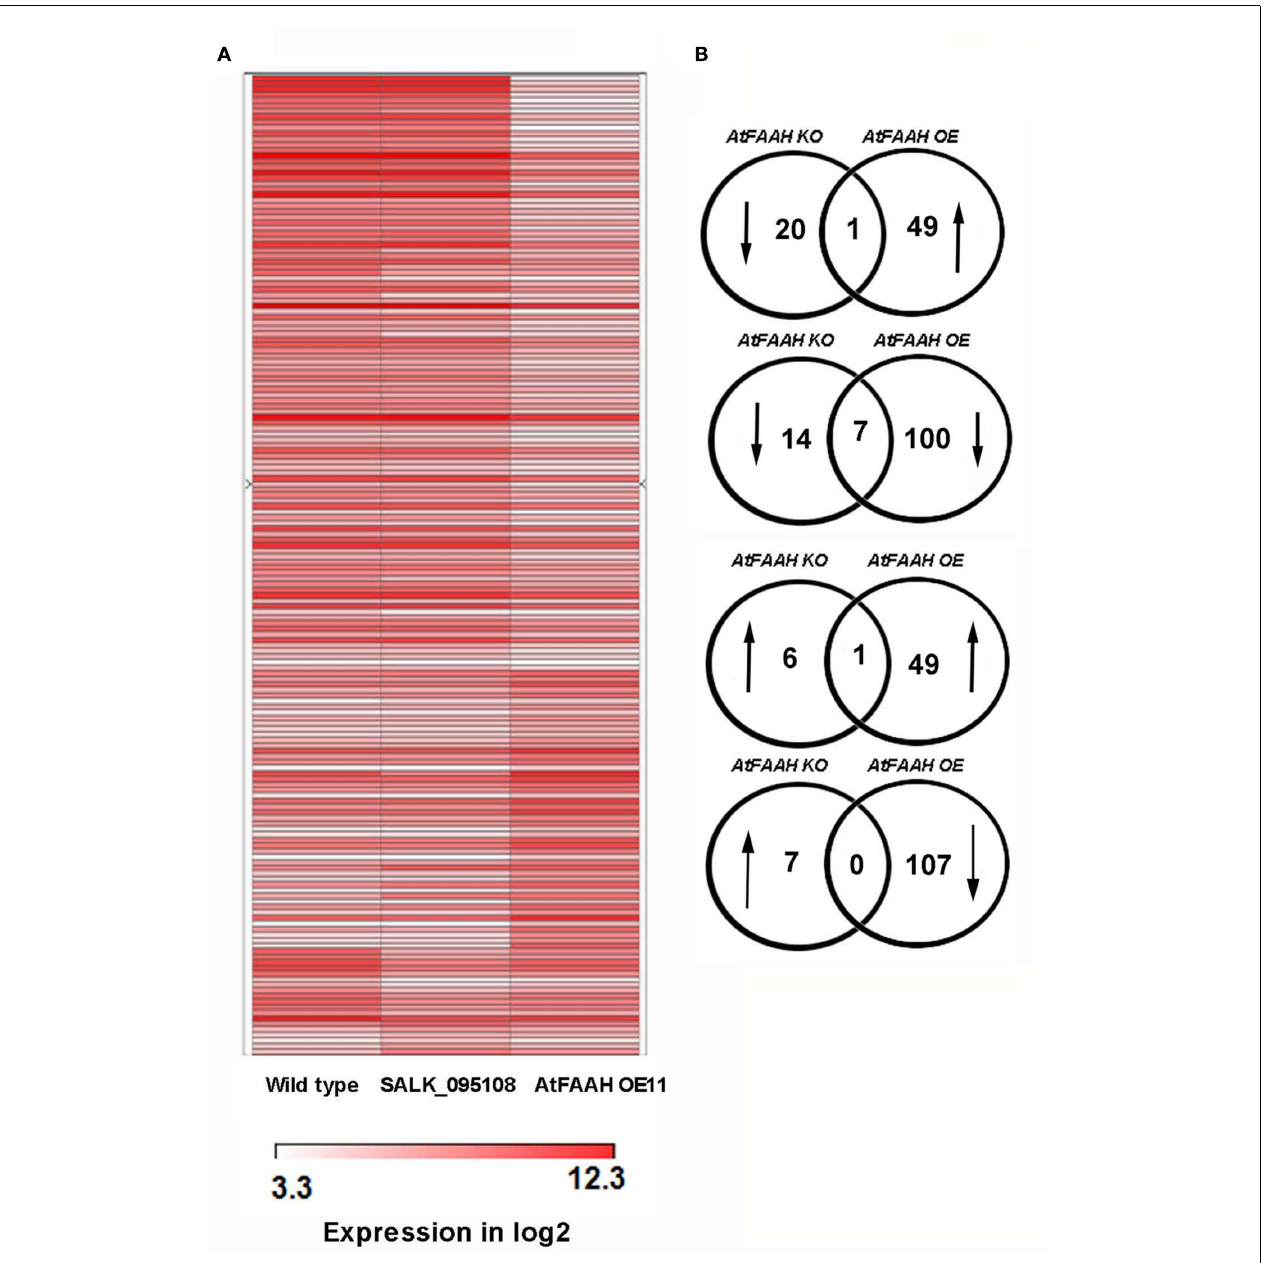
FIGURE 3 | AtFAAH overexpression triggers a more dramatic change in gene expression than AtFAAH knockouts. (A) Heat map of gene expression in wild type, AtFAAH knockout (SALK_095108) and AtFAAH